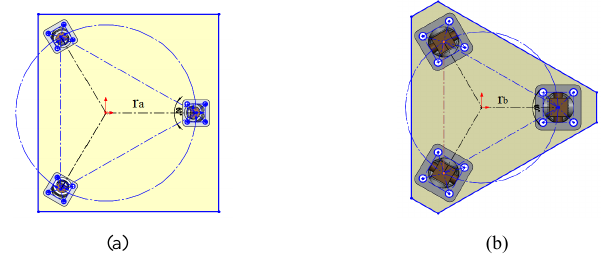
Figure 2. A scheme of arrangement of U-joints: (a) in the upper plate (waist); (b) in the lower plate (foot).